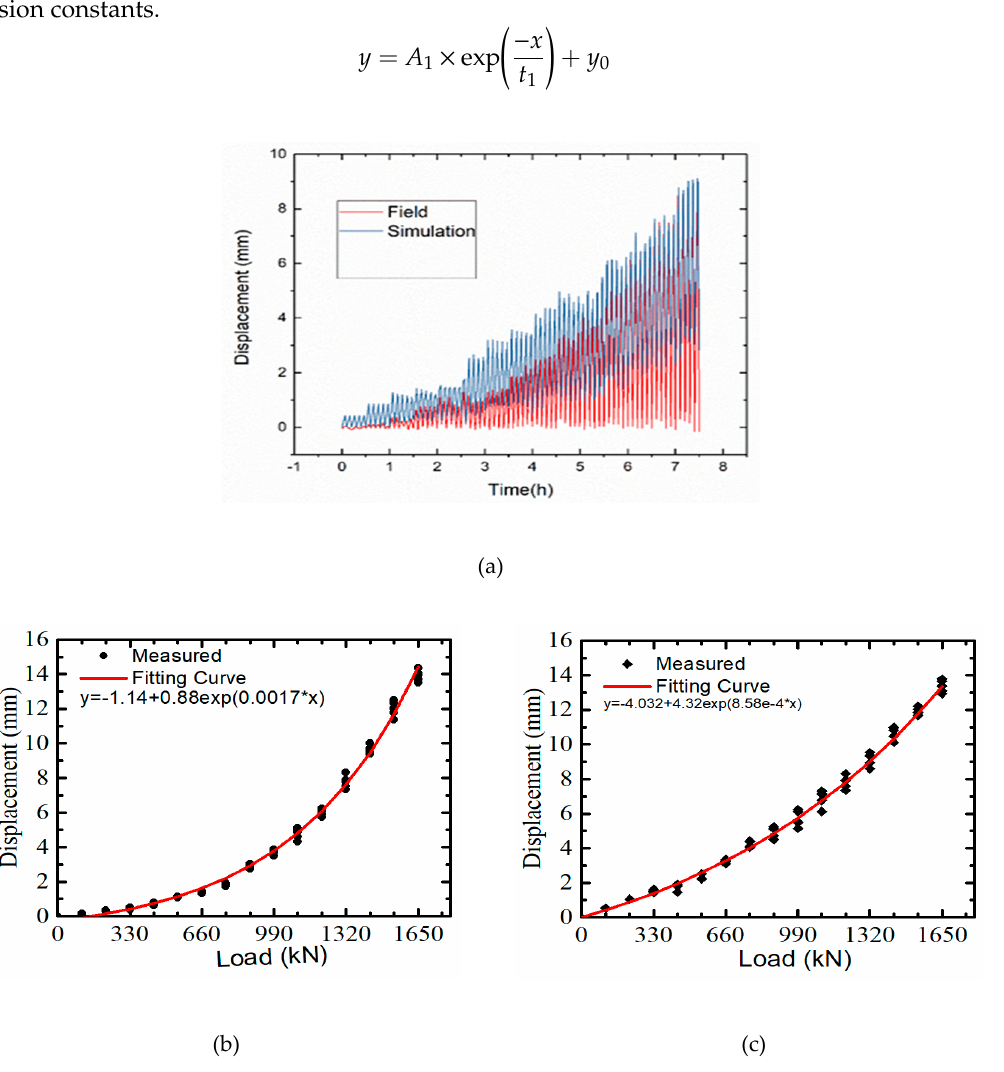
Figure 8. Comparison of lateral displacement between Field measurement and Finale Element (FE) Simulation result; ( a ) (H-t-Y0) the curve at the point of the ground surface test pile force FE Simulation result and field result; ( b ) Field measurement at the pile head; ( c ) FE Simulation result at the pile head.